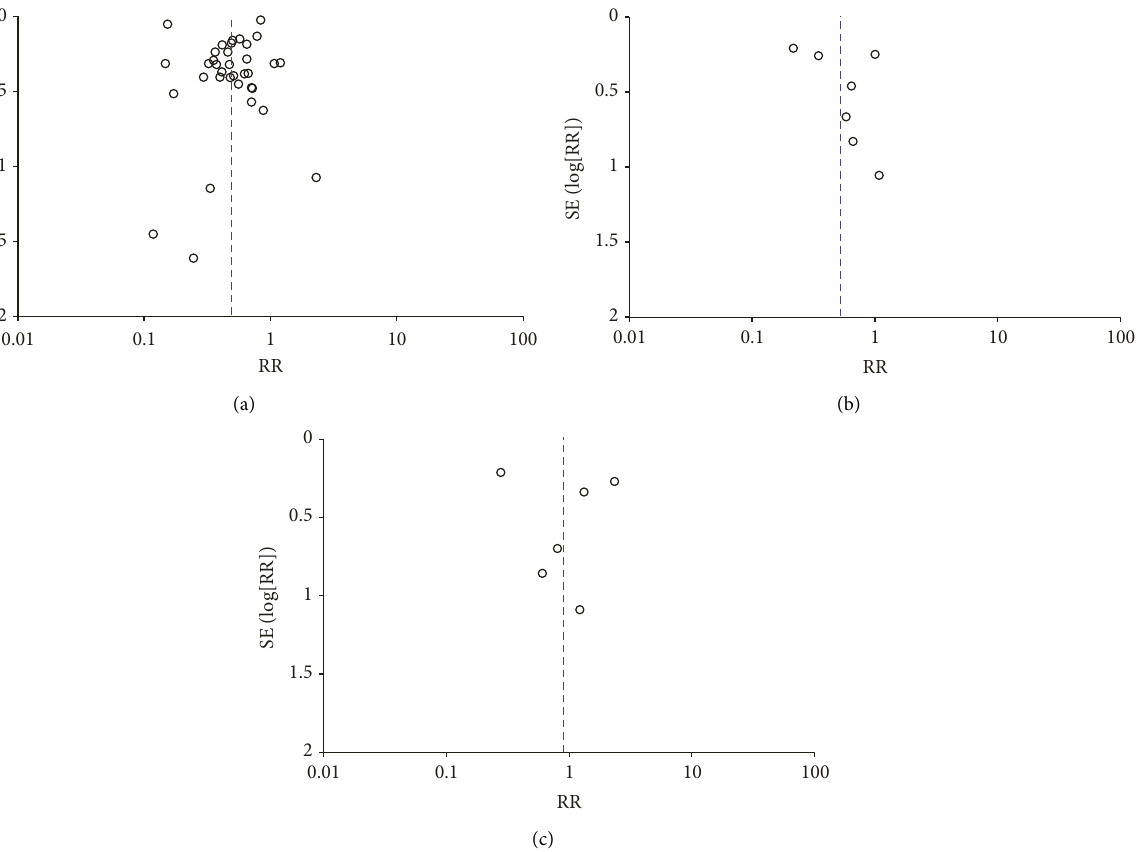
Figure 7: (a): Funnel plot for the risk of developing AKI between TF- and TA-TAVR approaches. (b) Funnel plot for the risk of developing AKI between TF- and TAo-TAVR approaches. (c) Funnel plot for the risk of developing AKI between TA and TAo TAVR